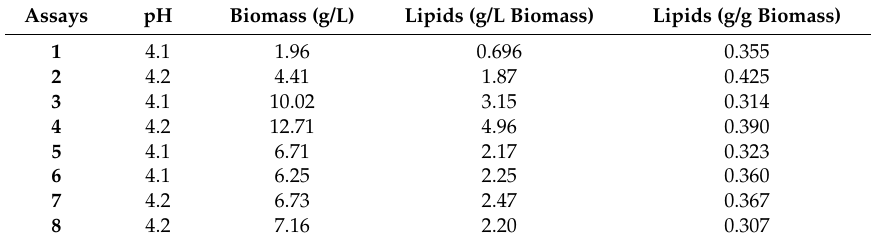
Table 3. Production of biomass and total lipids by Candida lipolytica using 2 2 factorial design.